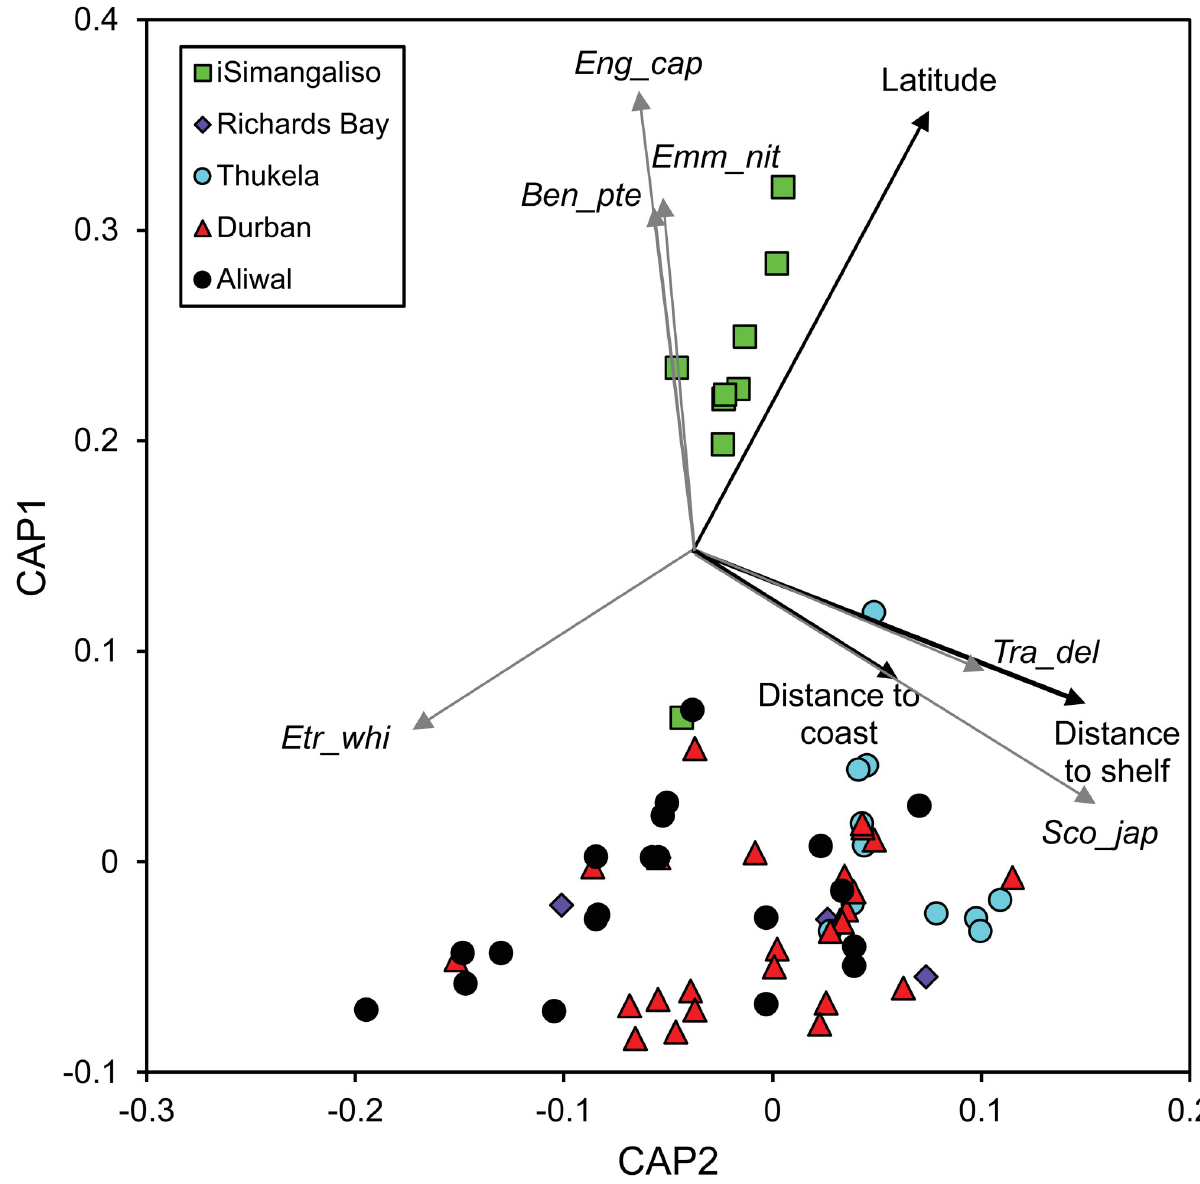
Fig 4. Constrained multidimensional scaling ordination derived from a canonical analysis of principle coordinates of ichthyoplankton samples, plotted according to transect. Vectors of the correlations of the significant environmental variables of interest (black) along with vectors (grey) of those species (abbreviated, see below) with correlations > 0.3 with the first two canonical axes are overlaid onto the ordination. The ordination accounted for 44% of the variation and the first and second squared canonical correlations were 0.65 and 0.36, respectively. Ben_pte = Benthosema pterotum , Emm_nit = Emmelichthys nitidus , Eng_cap = Engraulis capensis , Etr_whi = Etrumeus whiteheadi , Sco_jap = Scomber japonicus , Tra_del = Trachurus delagoa . correlations of -0.699, -0.604 and -0.572 with axis 3, respectively. The frequency of S . japonicus